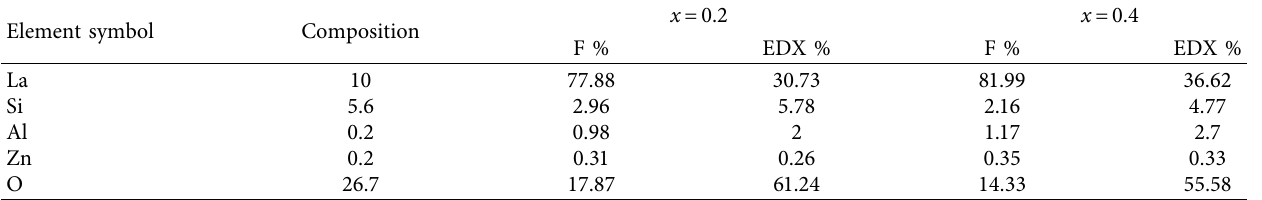
� 0.2 and 0.4) through EDX. 10 Si 6 − x − 0.2 Al x Zn 0.2 O 27 − δ ( x